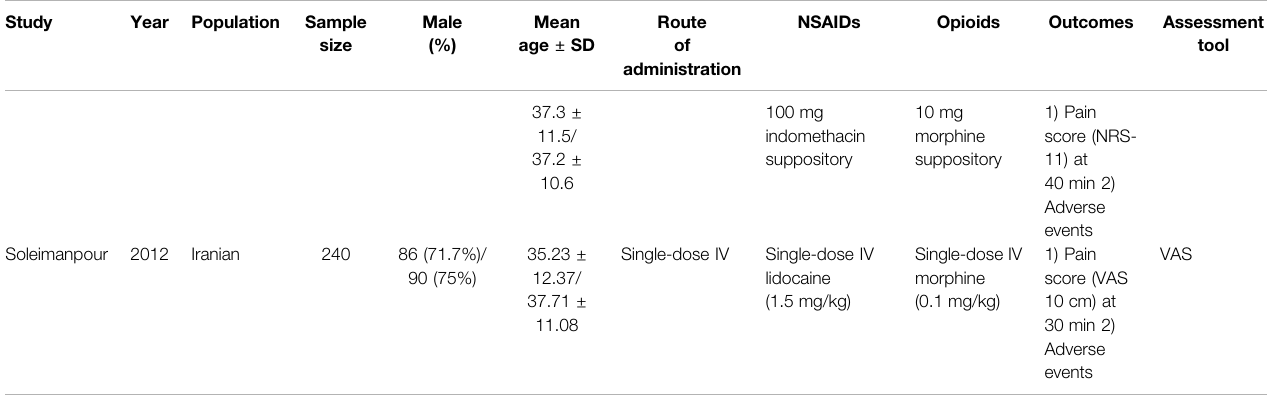
TABLE 1 | ( Continued ) Summary of included clinical trials and patient characteristics.